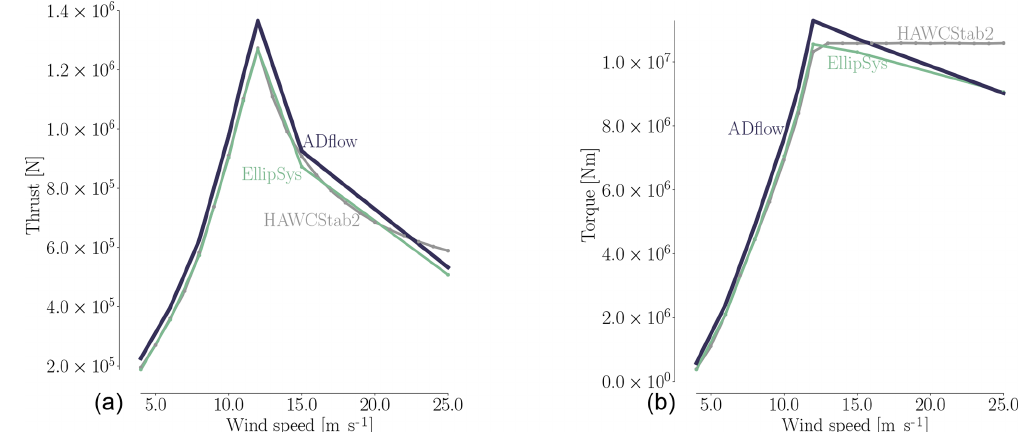
Figure A1. Total thrust (a) and torque (b) as a function of wind speed for the rotor geometry used as the starting point for the optimization computed using mesh L0. As expected, the torque increases rapidly from cut-in speed to the rated speed at 12ms − 1 , which is also where the thrust peak occurs. From rated to cut out, the torque curve flattens. Here, the pitch setting found with steady-state BEM results using HAWCStab2 (seen in gray) clearly does not result in the CFD solvers tracking rated power accurately due to the model changes. ADflow consistently overshoots the EllipSys results, which is consistent with the trend seen in Table 4. Operational conditions for the eight simulations are given in Table A1.